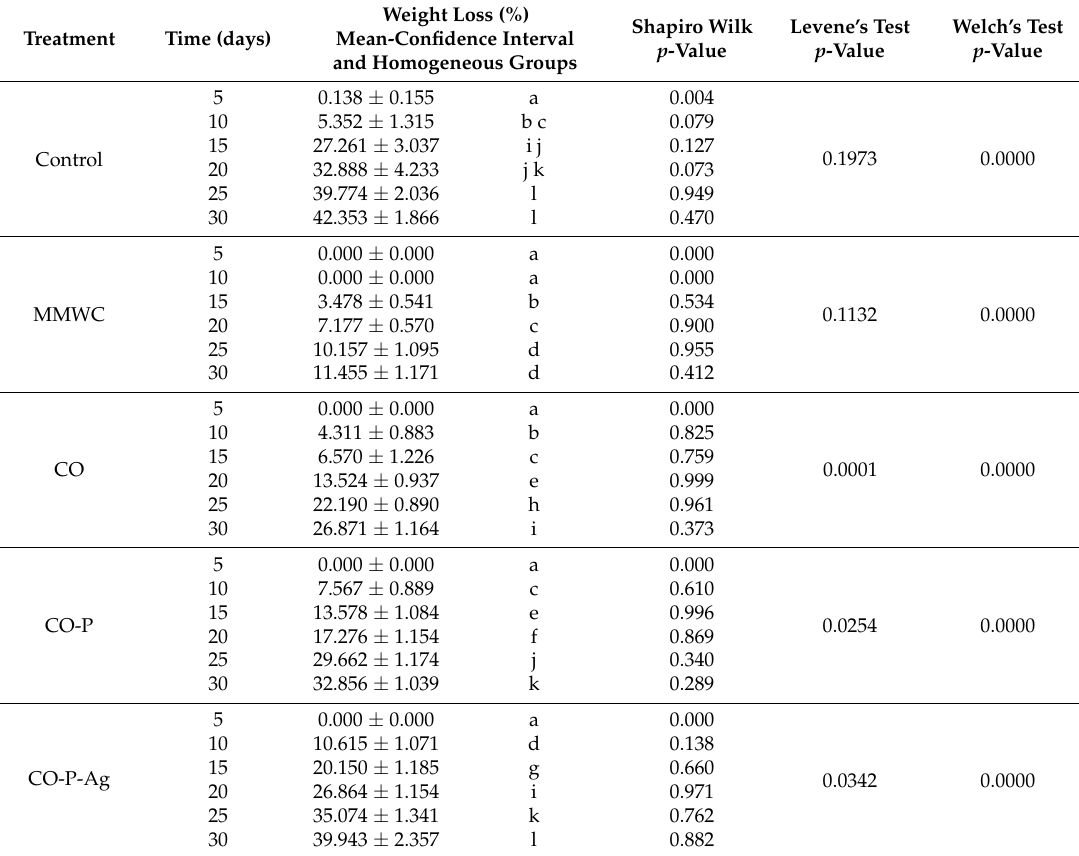
Table 3. Effect of coating treatments and time on weight loss for Populus spp. wood-blocks exposed to white-rot fungus T. versicolor